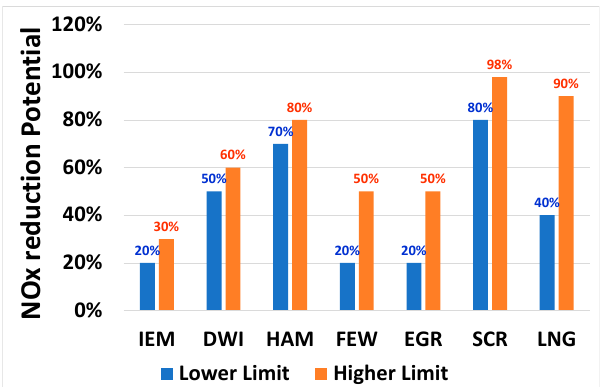
Figure 10. Comparison of the NO x reduction potential of various technologies that are implemented inside diesel engines (internal measures) and outside diesel engines at their exhaust (external measures). IEM means internal engine modification. All other abbreviated NO x reduction technologies have already been explained in the main text. (Figure was genuinely generated using data from ref. [60]).